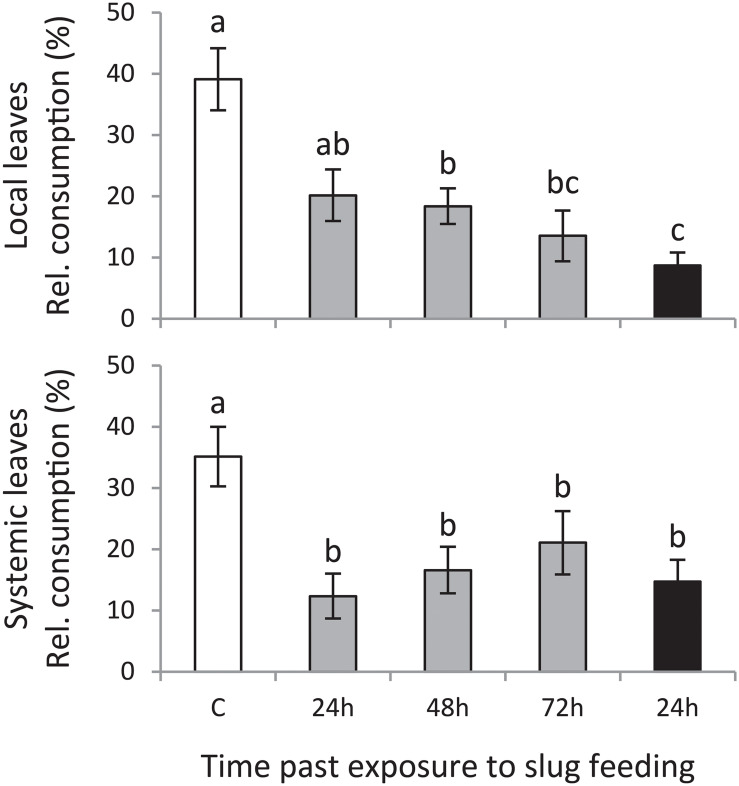
Mean consumed leaf area relative to the total consumed area (% ± SE, n = 12) on Solanum dulcamara leaf disks in preference assays with the gray field slug (GFS; Deroceras reticulatum). Slugs were offered leaf disks from plants that were exposed to an undamaged control treatment (C; white bar) or to feeding by GFS for 24 h (gray bars) or 72 h (black bar). Leaf disks were collected 24, 48, or 72 h after the end of the treatment period (see also Figure 1). Disks of either local or systemic leaves were offered in independent preference assays. Different letters over the bars indicate significant preference differences (P < 0.05) according to Conover post hoc test of Friedman ANOVA (χ2local = 17.065, Plocal = 0.002; χ2systemic = 11.661, Psystemic = 0.022) after Bonferroni correction of P-values for multiple comparisons.